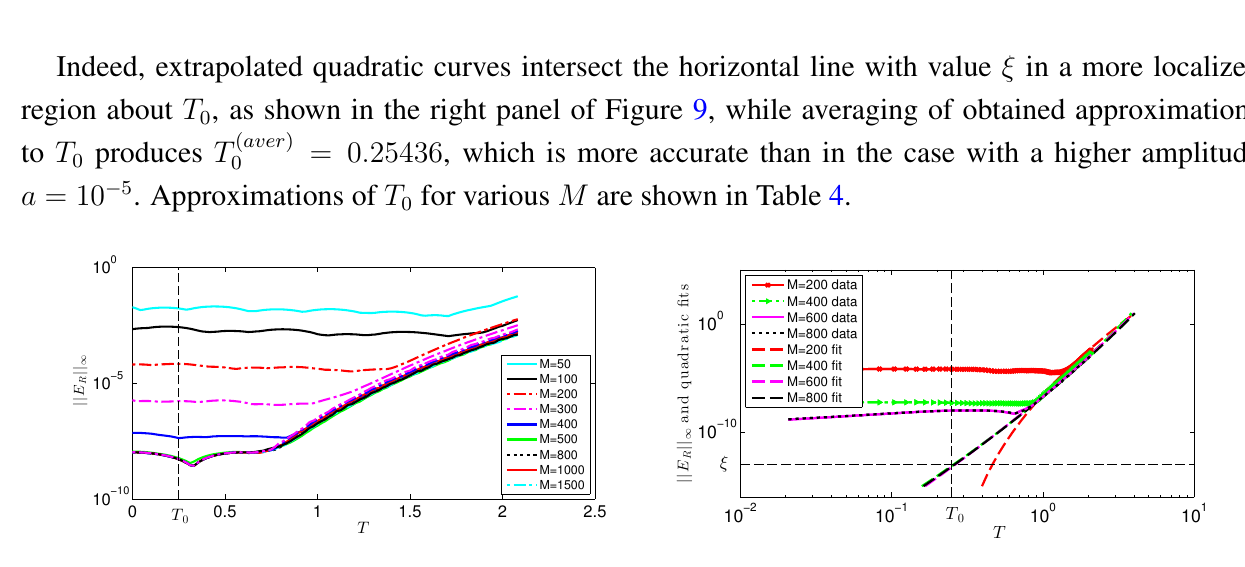
|| Left panel: evolution of || E in the four-pole example with the added R ∞ perturbation 10 − 8 sin(10 πx ) of a smaller amplitude. The dashed line corresponds to the exact = 0 . 25 . Right panel: || E || delay T in the four-pole example with the added perturbation 0 R ∞ 10 − 8 sin(10 πx ) and M = 200 , 400, 600 and 800 together with their extrapolated quadratic = 0 . 25 , while the horizontal fits. The vertical dashed line indicates the exact time delay T 0 dashed line indicates the level of filtering of singular values given by ξ = 10 − 13 .